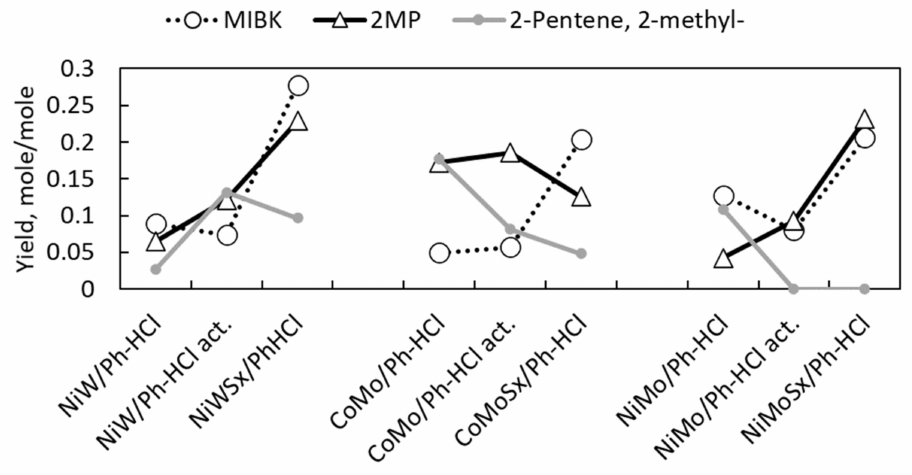
Figure 11. Yield of MIBK, 2MP, and MPe. The yield was calculated by the division of the moles produced of each compound and the initial amount of moles of